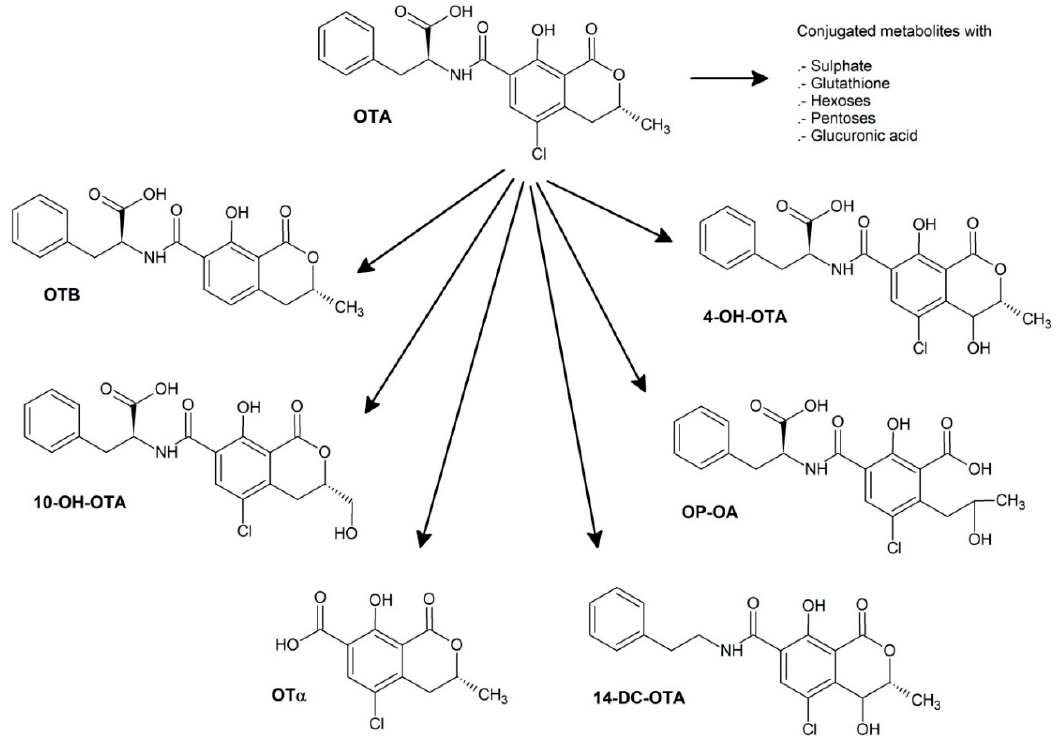
Figure 1. Structures of ochratoxin A ( OTA ) and transformation bioproducts ochratoxin B ( OTB ), 10-hydroxyochratoxin A ( 10-OH-OTA ), ochratoxin α ( OT α ), 14-decarboxy-ochratoxin A ( 14-DC-OTA ), lactone-opened OTA ( OP-OA ), 4-hyroxyochratoxin A ( 4-OH-OTA ) and OTA conjugated metabolites adapted from [23–25].